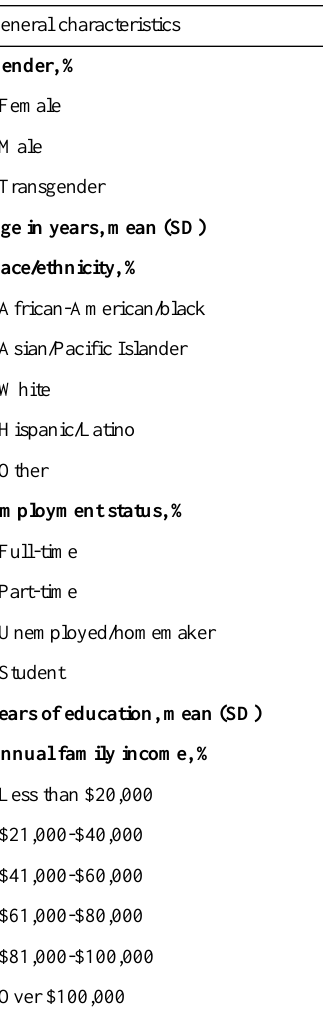
Table 1. Demographic and smoking characteristics of young adults who completed the survey (N = 1548)